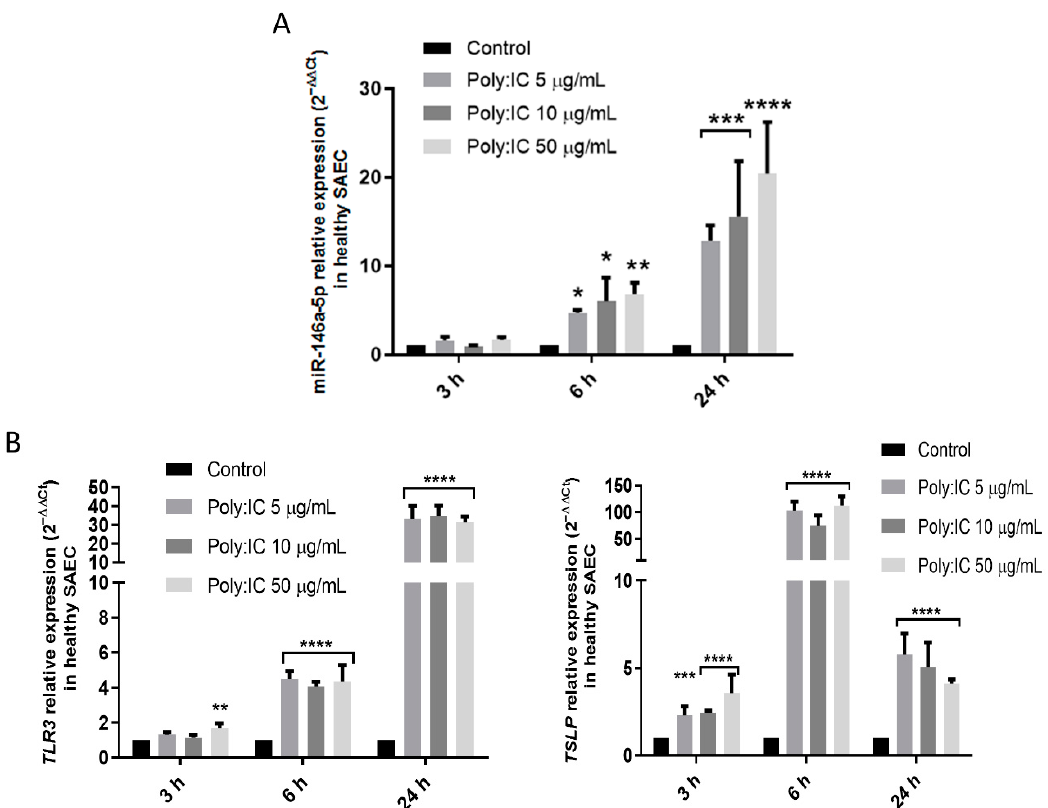
Figure 4. miR-146a-5p levels are increased when exposed to viral analog stimuli in healthy airway epithelial cells. ( A ) miR-146a-5p expression (2 −ΔΔ Ct ) increases in SAECs after stimulation with poly:IC in increasing doses (5, 10, and 50 µg/mL). ( B ) TLR3 and TSLP expression (2 −ΔΔ Ct ) are augmented in SAEC after stimulation with poly:IC in increasing doses (5, 10, and 50 µg/mL). SAEC: Small airway epithelial cells. * p < 0.05; ** p < 0.01; *** p < 0.001; **** p < 0.0001 (compared to the untreated control group).